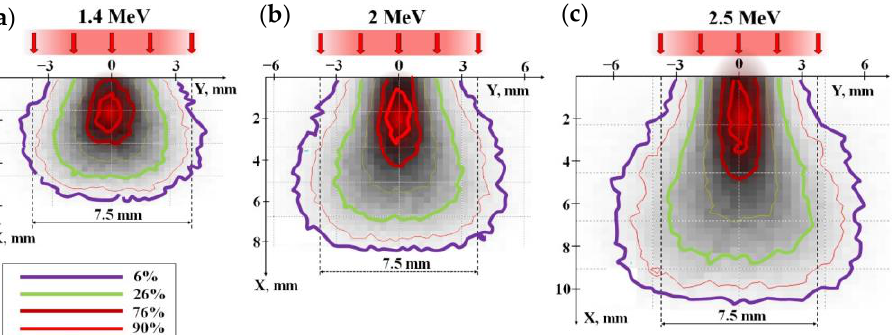
Figure 1. Energy loss distribution of electrons with E = 1.4 ( a ), 2.0 ( b ), 2.5 ( c ) MeV in a mixture with a bulk density of 1.2 g/cm 3 for the synthesis of Y 3 Al 5 O 12 ceramics. Colored lines of equal loss are given in units relative to the loss in the center.